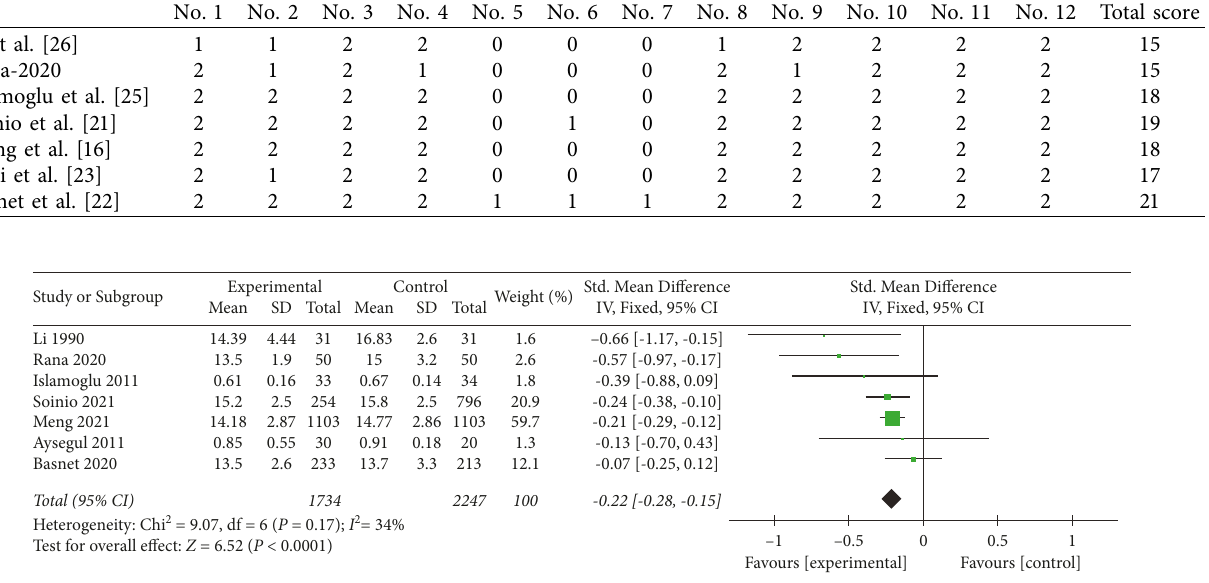
Figure 2: Forest diagram.